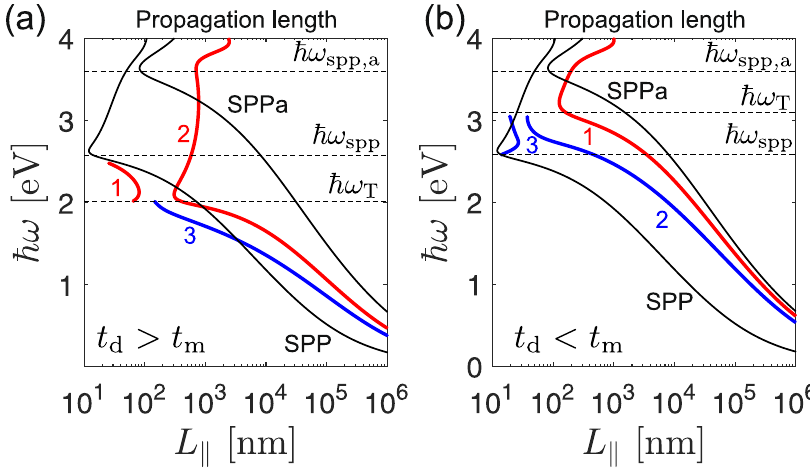
Figure 8. In-plane propagation length L || for TPMs whose dispersion of Re{ β n ( ω )} is drawn in ( a ) Figs 7 and ( b ) and 9. The solid lines denoted as SPP and SPPa are the L || values corresponding to the ε d − ε m and ε a − ε m interface SPPs.